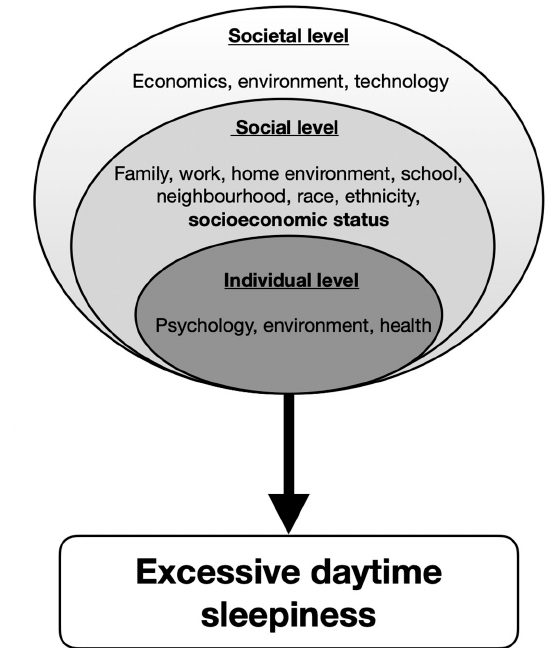
Figure 2. The biopsychosocial model of excessive daytime sleepiness.